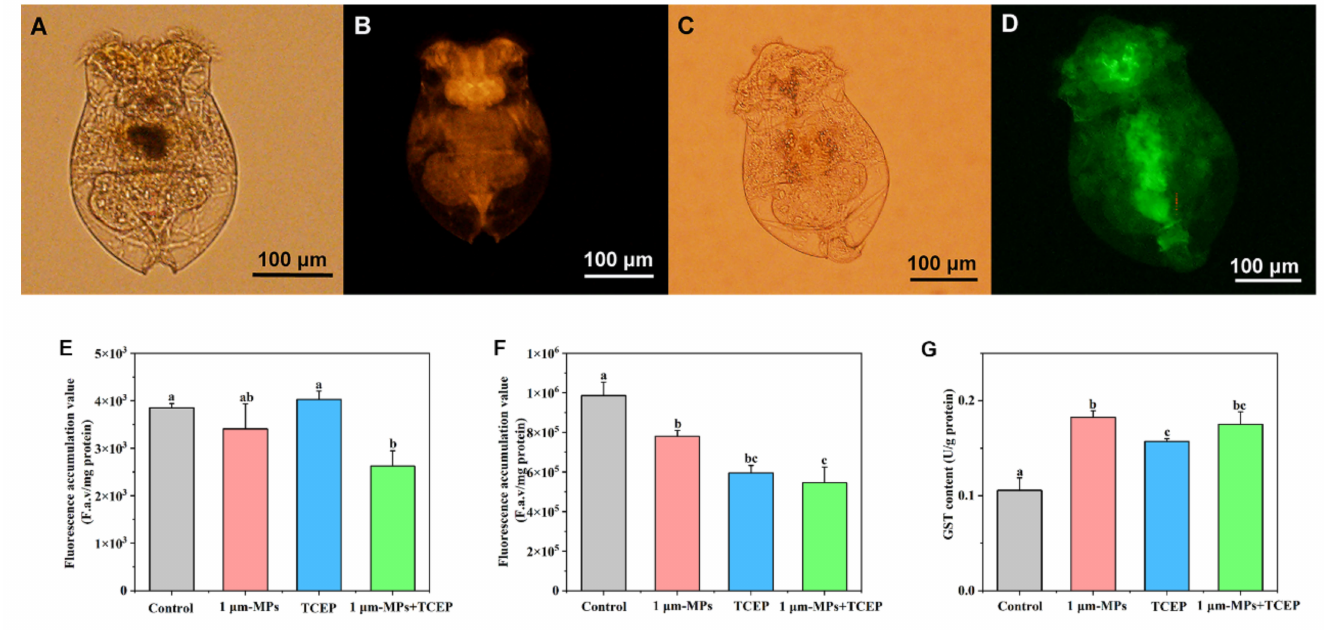
Figure 7. Effect of 1- µ m MPs + TCEP at high concentration on the activities of MXR key components of B. plicatilis (n = 30,000). Images of rotifers after staining of rhodamine B ( A , B ) and calcein AM ( C , D ): ( A,C ) rotifers under light microscope; ( B , D ) rotifers under fluorescence microscope; ( E ) retention amounts of rhodamine B; ( F ) retention amounts of calcein AM; ( G ) GST activities. Data are expressed as the mean ± SD of three parallel experiments. Different lowercase letters represent significant differences between experimental groups ( p <